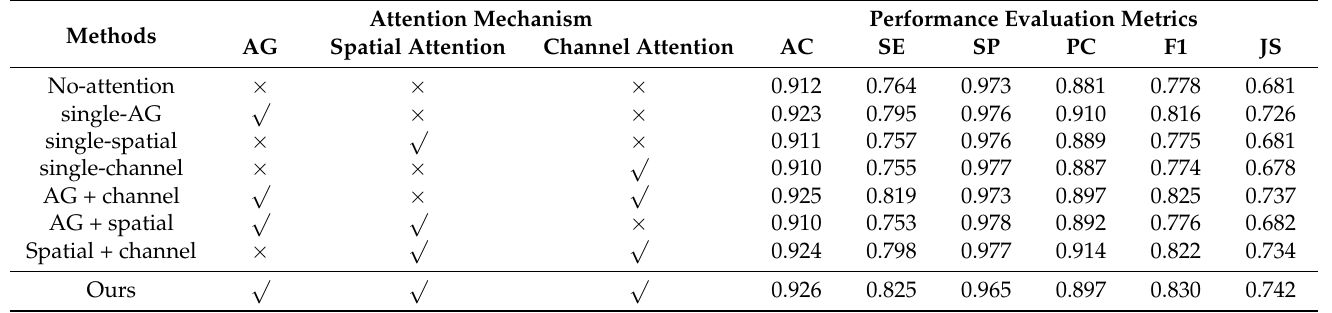
Table 5. Performance comparison of different attentional mechanisms on the ISIC-2017 dataset.